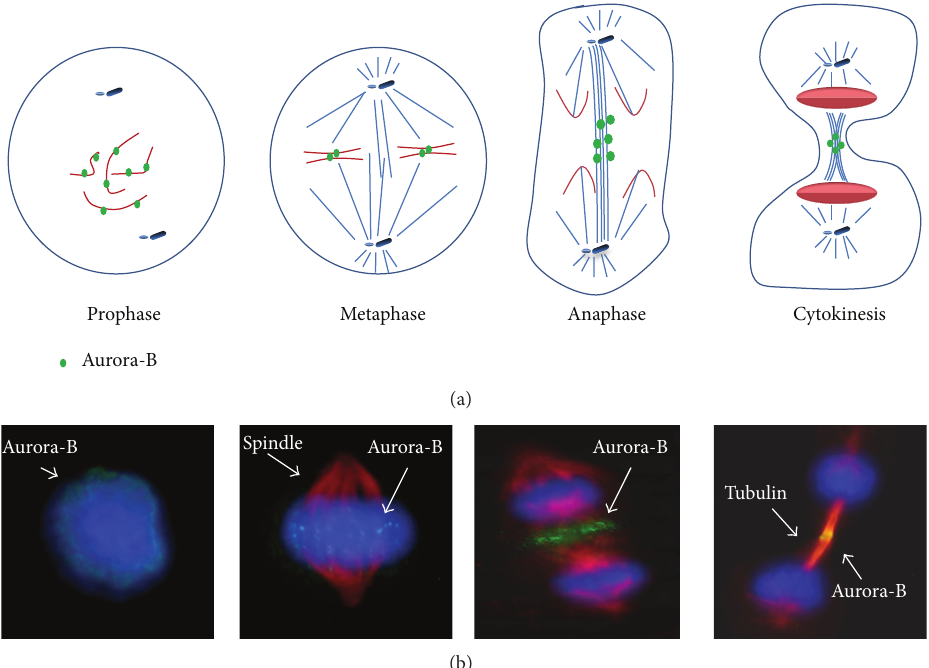
Figure 3: Schematic representation (a) and immunofluorescence images (b) of Aurora-B localization during mitosis in an anaplastic thyroid cancer cell. In (b) Aurora-B is in green, microtubules are in red, and DNA, stained by DAPI, is in